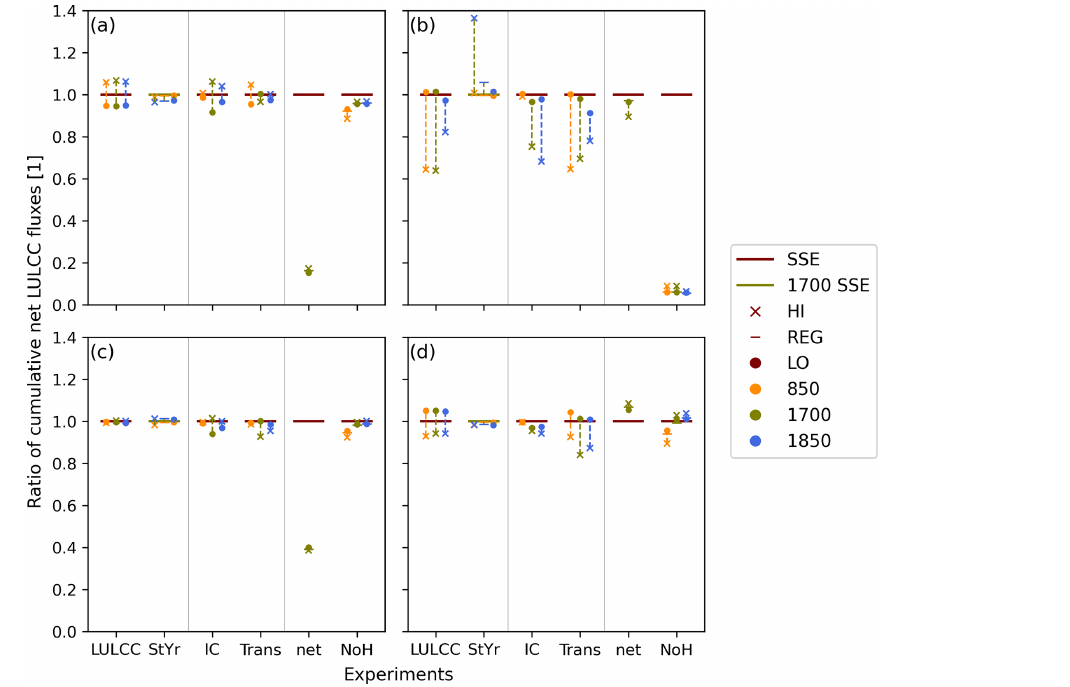
Figure 4. Global cumulative net LULCC flux as in Fig. 3a for the period 1850–2014 but separated by LULCC activity: (a) abandonment, (b) harvest, (c) crop expansion and (d) pasture expansion. Normalisation is done individually for each LULCC activity. SSE refers to the standard sensitivity